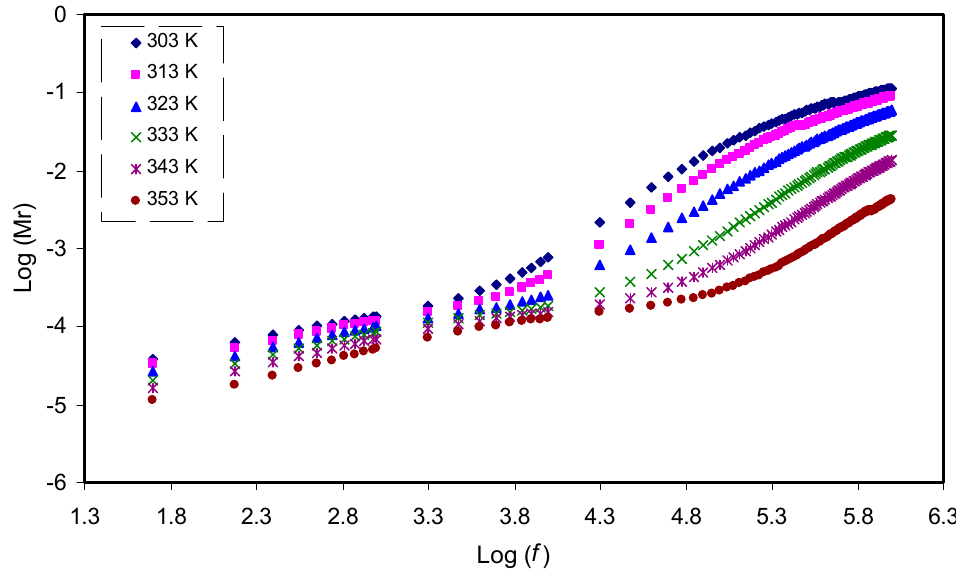
Figure 7. Frequency dependence of the real part (M r ) of M* for the CS: POZ: MgTfsystem at different temperatures.